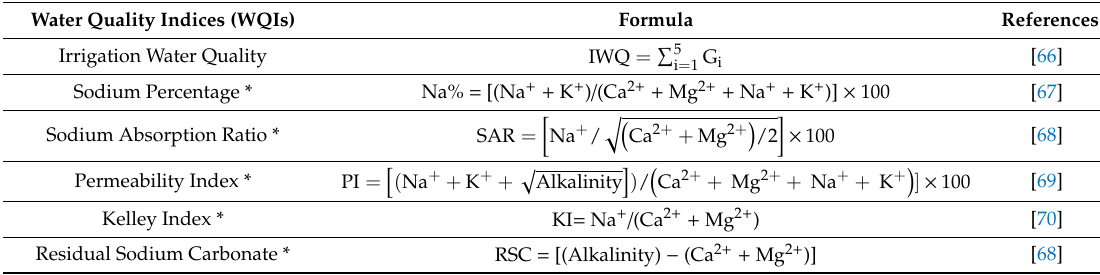
Table 1. Water quality indices for irrigation, formula and references. * All Water Quality Indices (WQIs) are estimated in meq / L except Irrigation Water Quality (IWQ), which is estimated in mg / L. Water Quality Indices